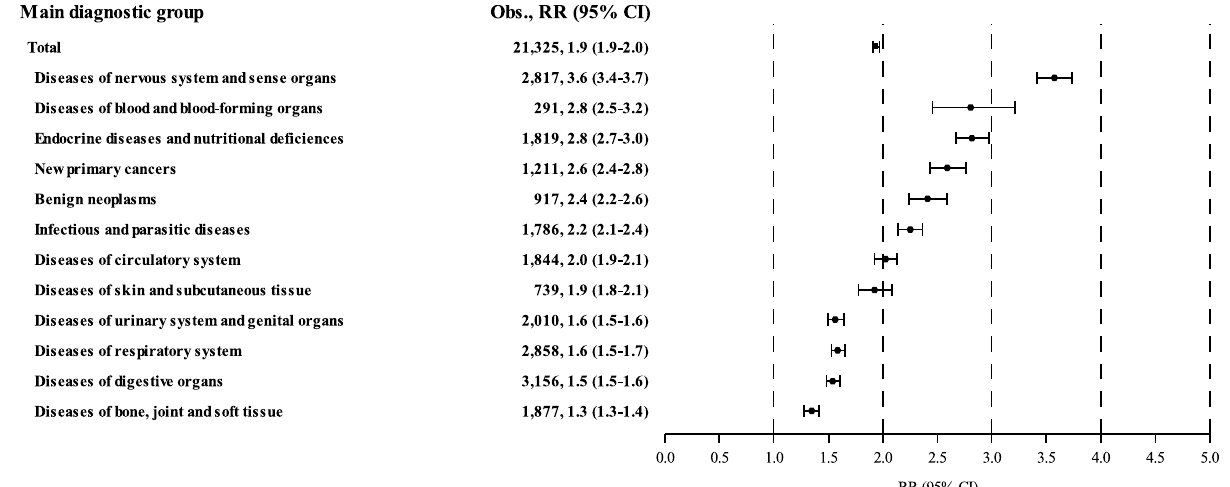
Fig 2. Risk of hospitalisation for somatic diseasesin each of 12 main diagnostic groups. 95% CI, 95% confidenceinterval; Obs., observed; RR, standardised hospitalisation rate ratio.